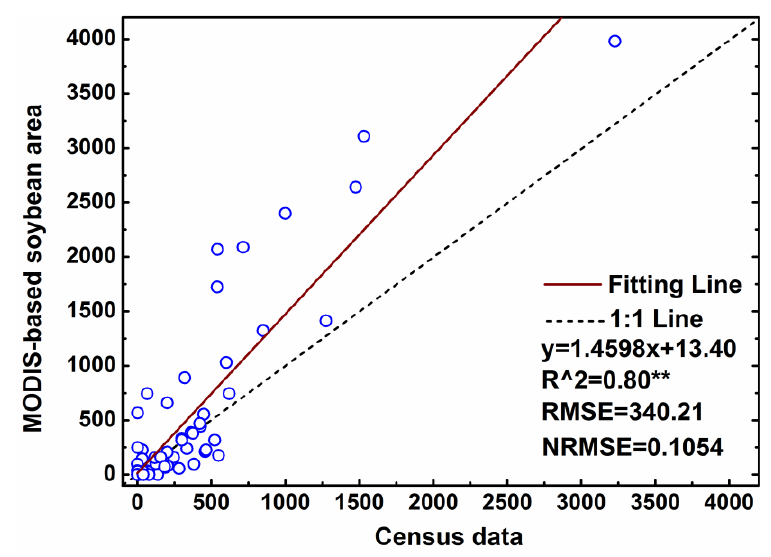
Figure 10. Regression-based comparisons between the MODIS-based soybean area estimates and census data respectively at county level. ** Significant at the α = 0.001 level.